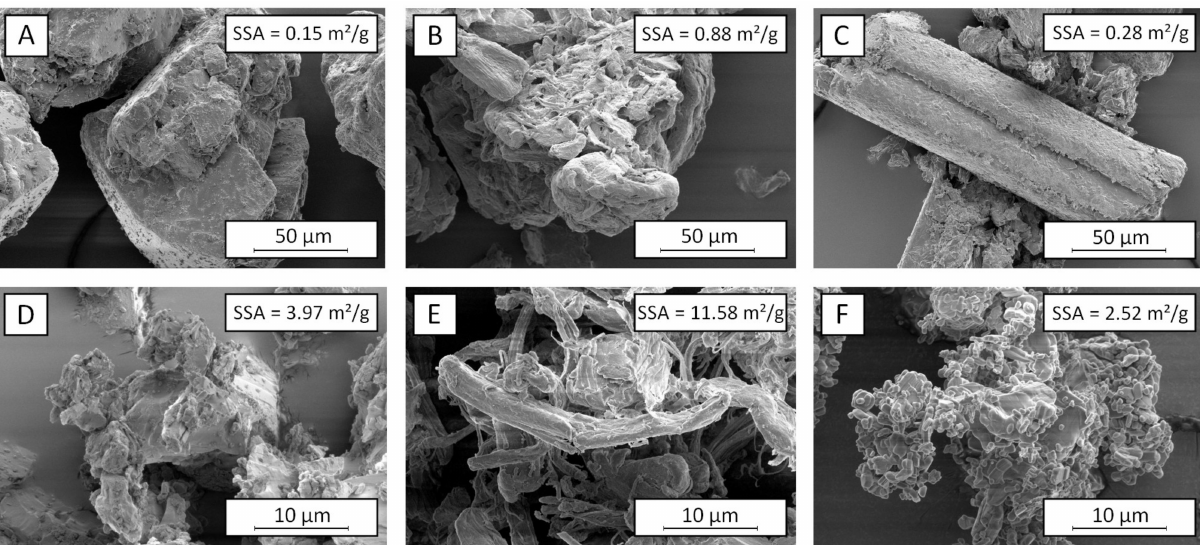
Figure 2. SEM images of raw materials and materials ground to an x 50,dry of approximately 5 µ m and their specific surface areas (SSA) calculated from octane-BET measurement using iGC: ( A ) Raw lactose, ( B ) raw MCC, ( C ) raw theophylline, ( D ) ground lactose, ( E ) ground MCC, ( F ) ground theophylline, un-stabilized, respectively. Magnifications of 2000 × ( A – C ) and 10,000 × ( D – F ),